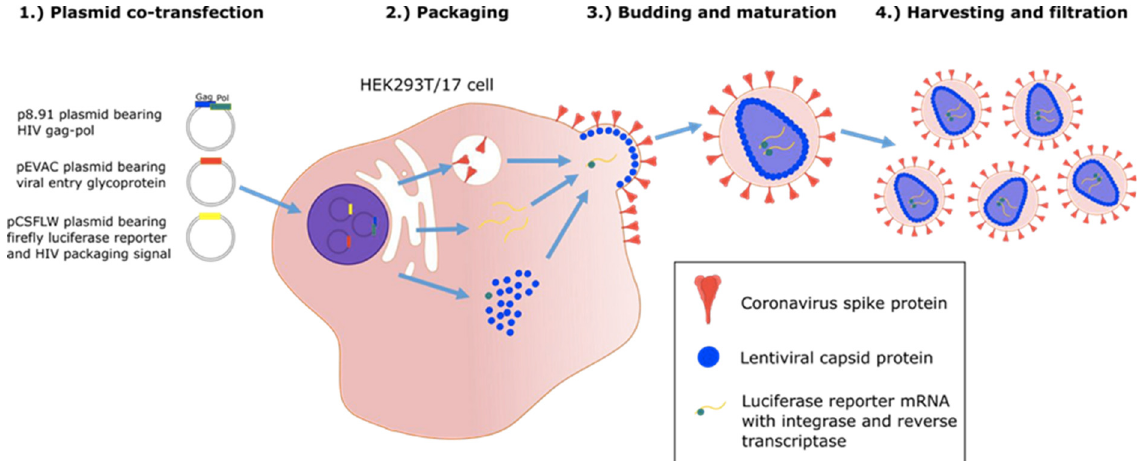
Figure 4. Graphic illustration of production of “pseudo-type virus” expressing envelope proteins such as coronavirus spike protein which are correctly post translational modified [24].